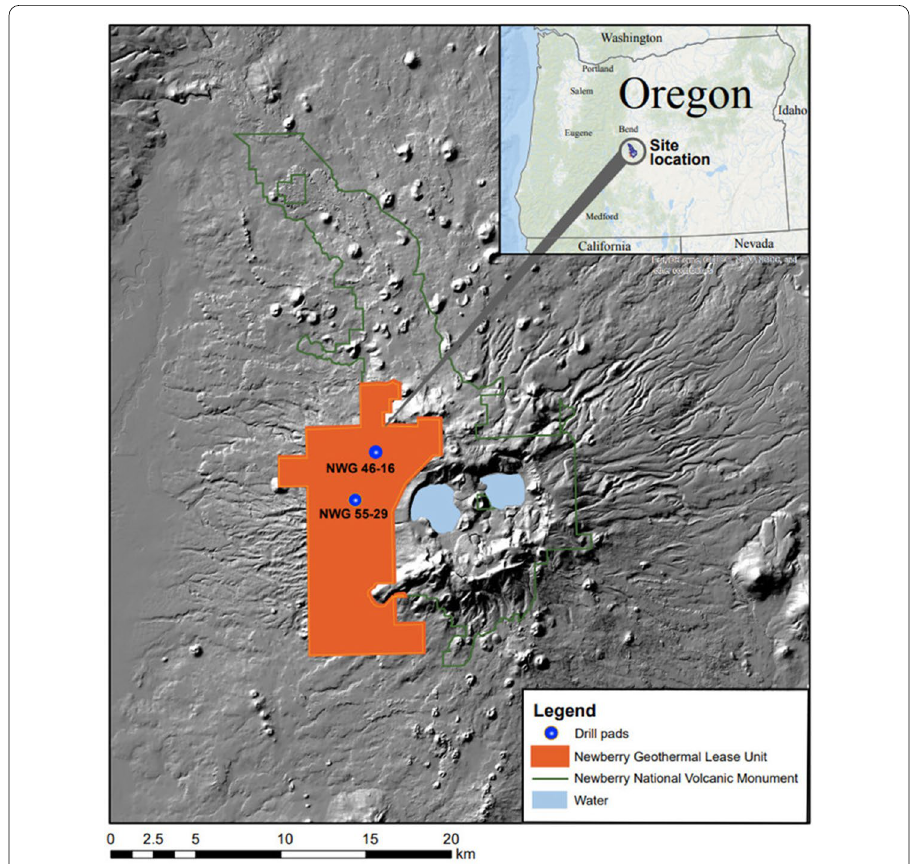
Fig. 1 NDDP site. NWG 46-16 and NWG 55-29 wellbore locations (Bonneville et al.